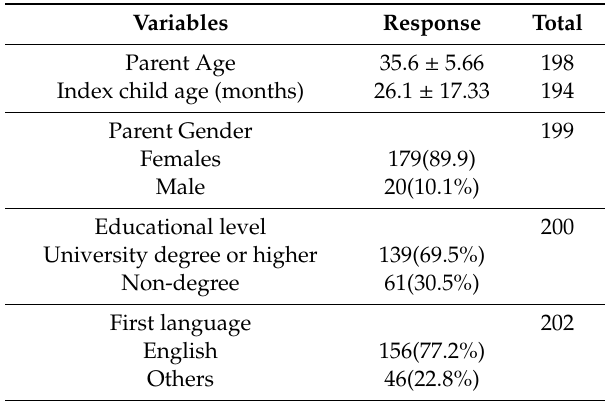
Table 1. Demographic characteristics of